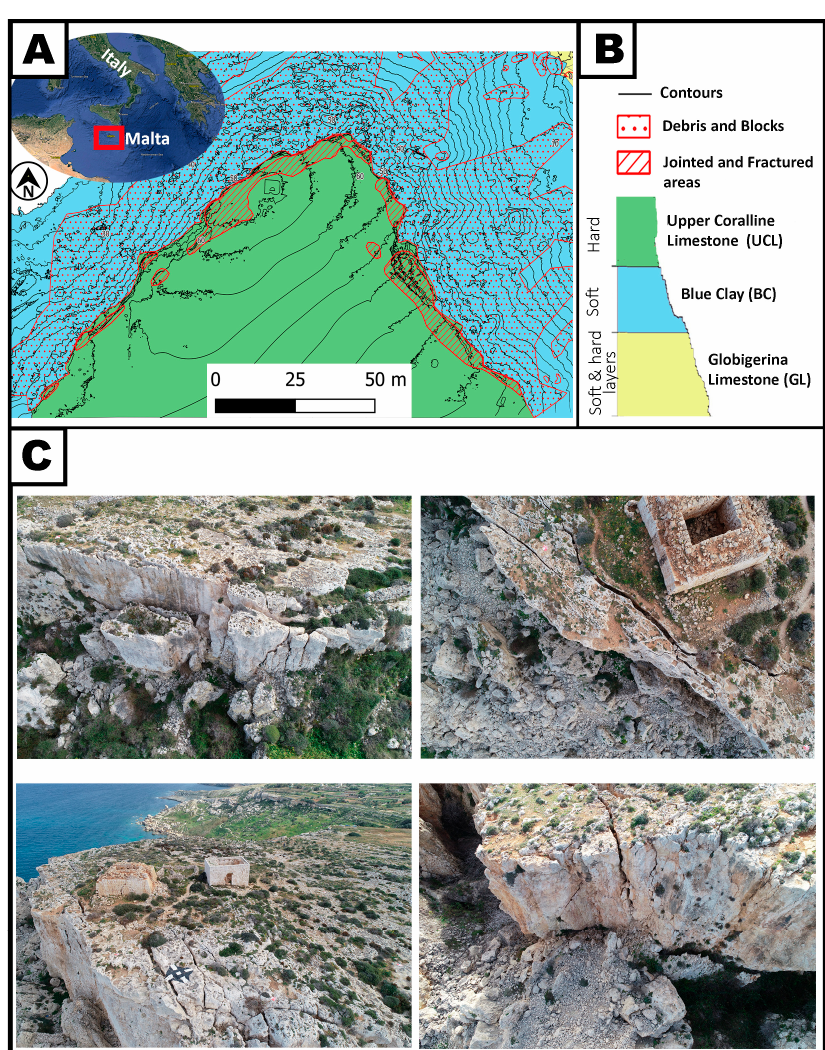
Figure 1. ( A ) Location of the Maltese islands in the Mediterranean Sea and the geomorphological map of the Selmun promontory (Malta) in GIS platform (scale 1:2500) [1]; ( B ) legend with the sedimentary sequence in the study area; ( C ) drone photographs showing the Upper Coralline Limestone cliff and its opened joints.